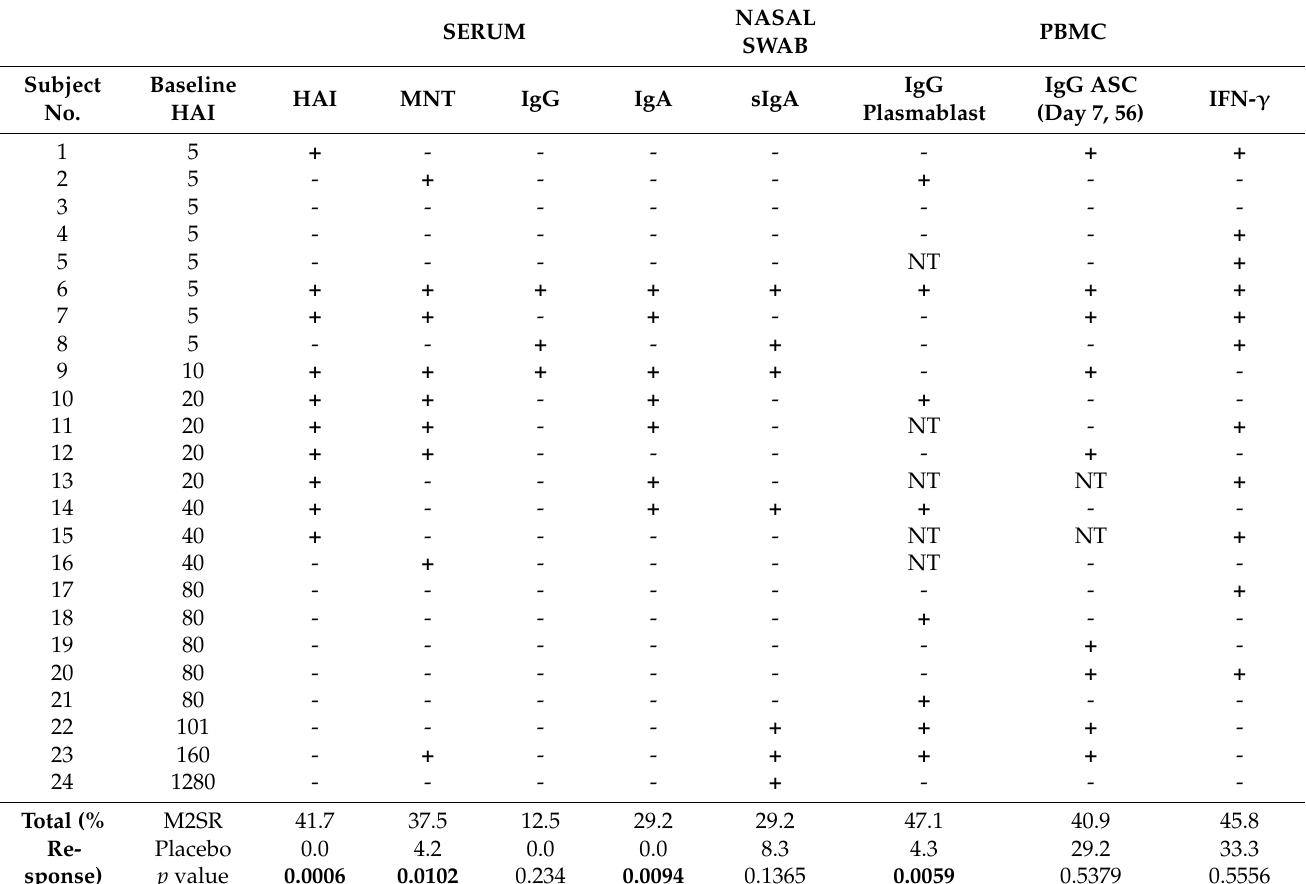
Table 3. Summary of immune responses for high-dose M2SR